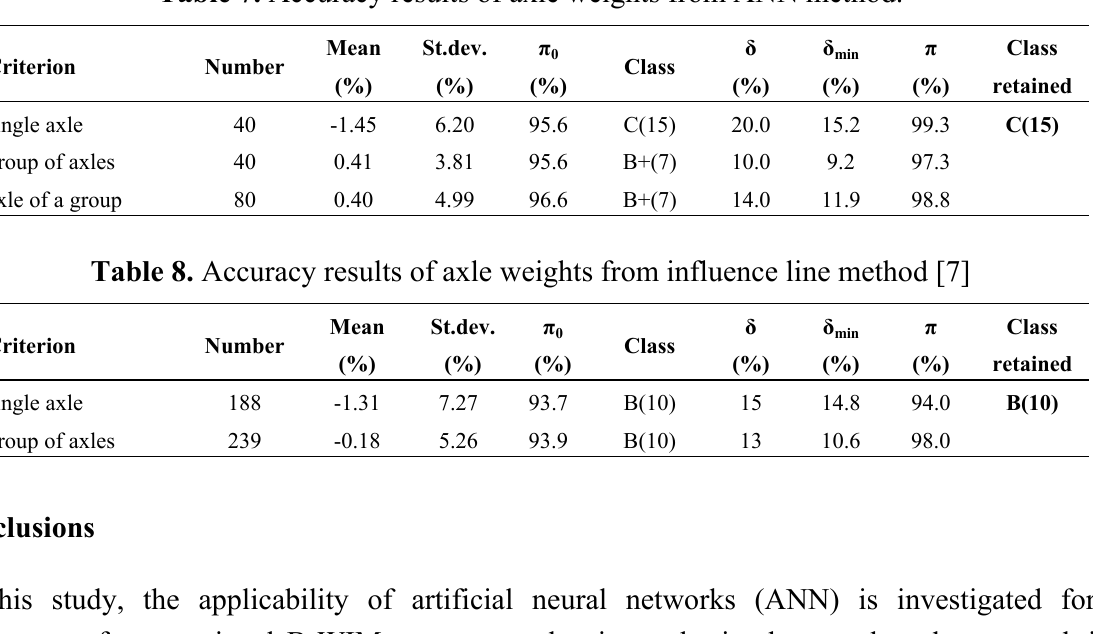
Table 7. Accuracy results of axle weights from ANN method.